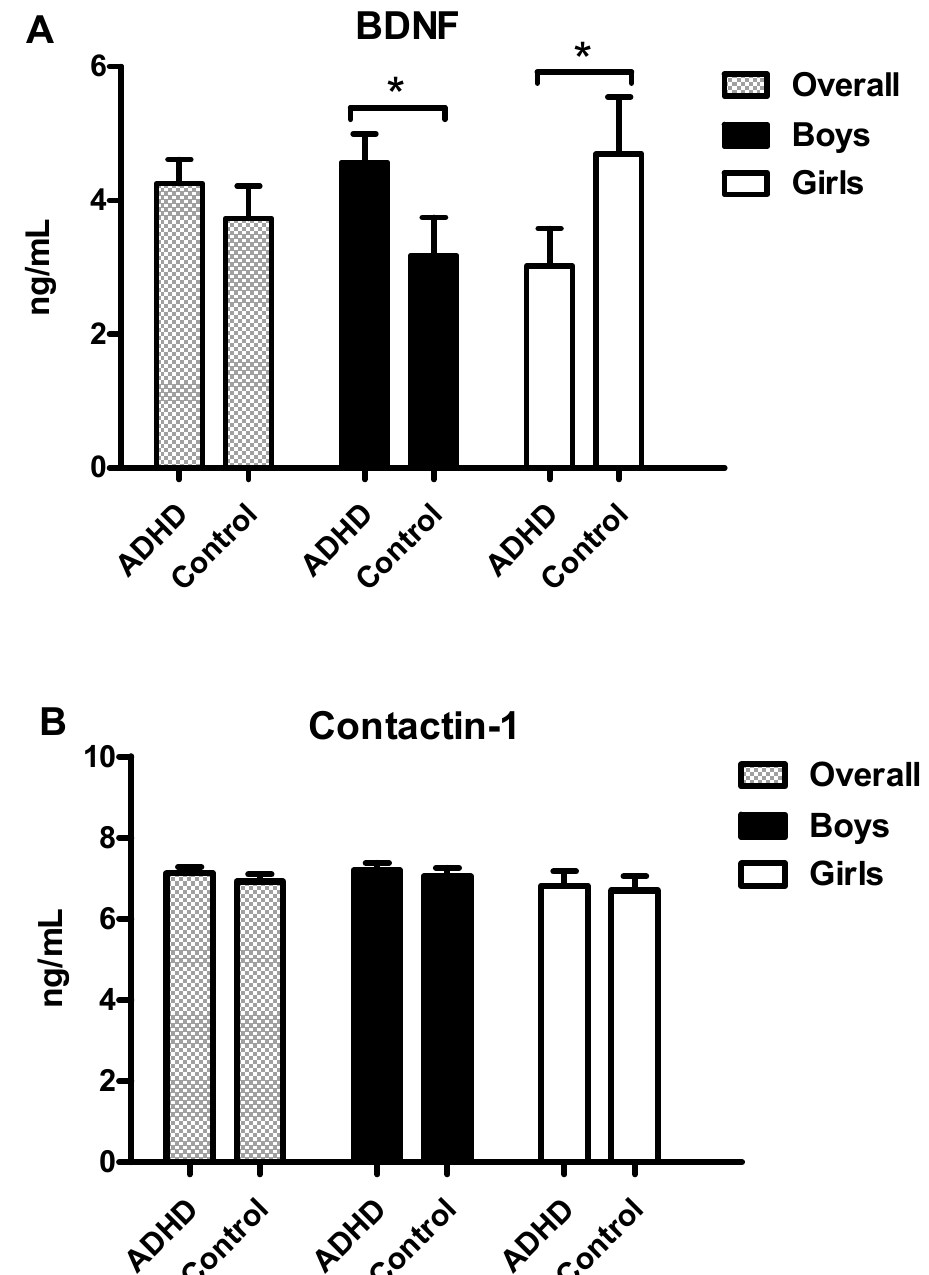
Figure 1. Plasma levels of BDNF ( A ) and contactin-1 ( B ) in patients with ADHD and healthy controls among all subjects, boys and girls. * p < 0.05.